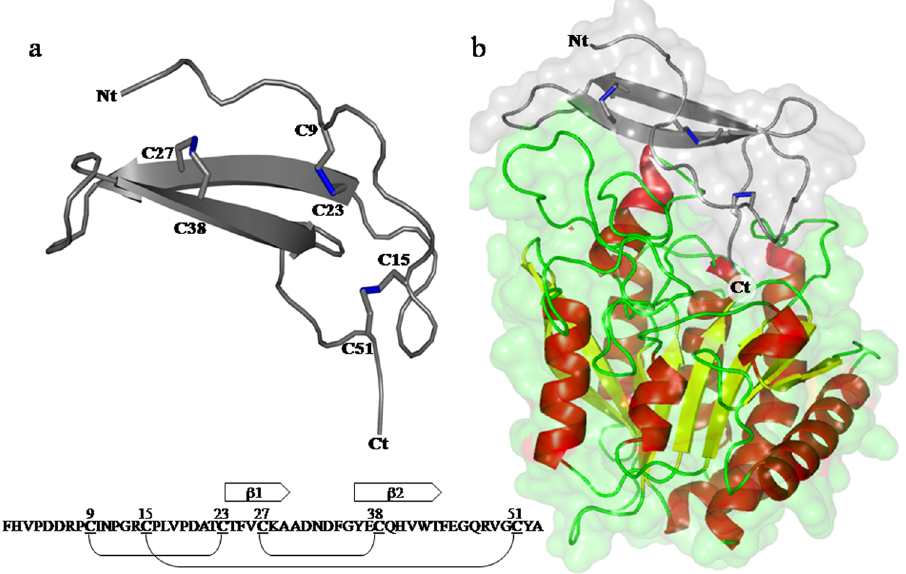
Figure 1. Schematic view of the native three-dimensional structure of NvCI and the NvCI-hCPA4 complex. ( a ) Schematic view of the ribbon representation of NvCI. The cysteine residues are depicted in the structure and the disulfide bonds are shown in stick representation ( blue ). The amino acid sequence of NvCI and its secondary structure elements and disulfide pairing are schematically shown at the bottom. The inhibitory site for MCPs comprises two residues (Tyr52 and Ala53), located at the C terminal tail, after Cys51. ( b ) Surface and ribbon representation of human CPA4 (hCPA4) in complex with NvCI ( gray ). The three disulfide bridges formed in NvCI are shown in stick representation ( blue ). The α -helix, β -strands, and coils of hCPA4 are highlighted in red , yellow , and green color, respectively. Ct and Nt stands for C terminus and N terminus, respectively. The Protein Data Bank accession number for the structure of NvCI in complex with hCPA4 is 4A94. All figures were prepared with